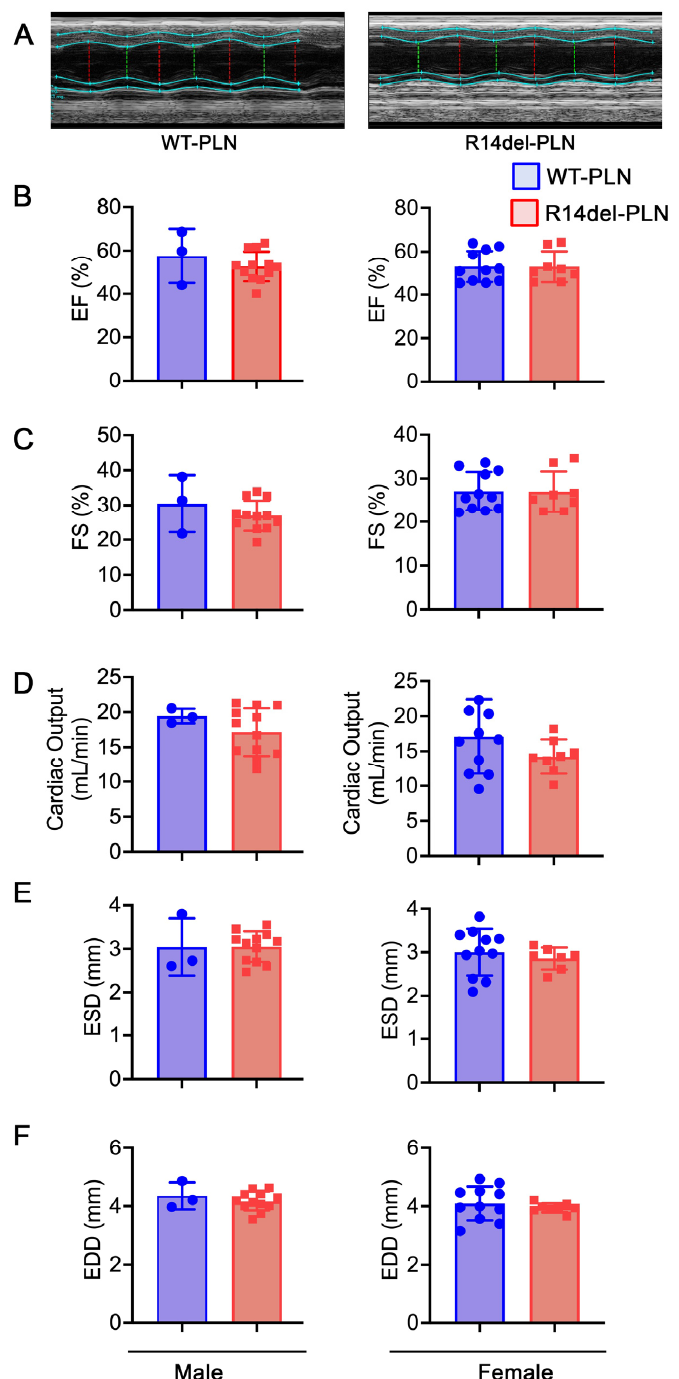
Figure 6. R14del- PLN mice exhibit no evidence of cardiac dysfunction or remodeling. ( A ) Sample M-Mode echocardiograms of male WT- PLN and R14del- PLN mice at 12 months of age. Quantitative analysis of echocardiographic parameters included ( B ) Ejection fraction (EF%); ( C ) Fractional shortening (FS%); ( D ) Cardiac Output (CO); ( E ) Left ventricular internal dimension, diastole (LVID;d); and ( F ) Left ventricular internal dimension, systole (LVID;s). Values represent mean ± SD; n = 3 for WT- PLN males; n = 12 for WT- PLN females; n = 12 for R14del- PLN males; and n = 8 for R14del- PLN females. 2.5. Increased Fibrosis and Altered Sarcomere Structures in R14del-PLN Hearts at 12 Months of Age To assess cardiac pathology in 12-month-old WT- PLN and R14del- PLN hearts, we used Picrosirius Red staining of fixed cardiac tissue sections. Pathological analysis revealed